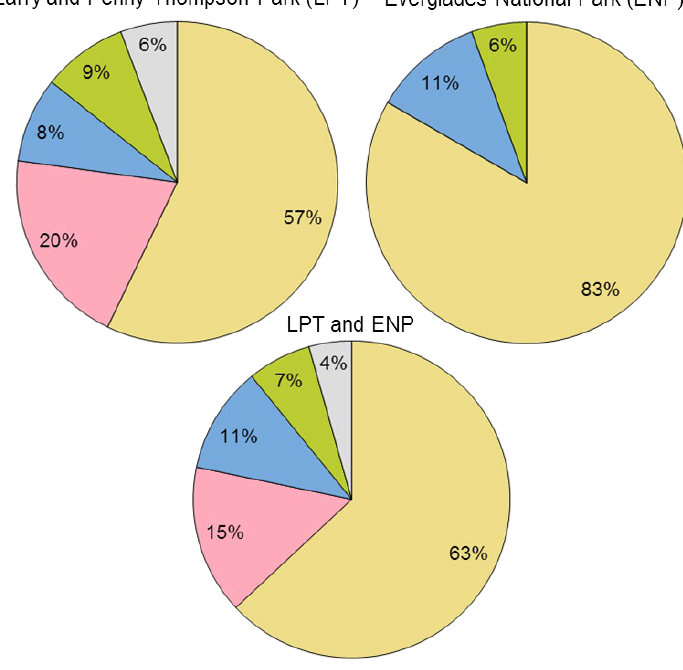
Figure 8. Relative usage of plant resources provided by Guettarda scabra , among arthropods in pine rockland habitats in south Florida USA. Percentages represent the fraction of species benefiting from a particular resource, with respect to the total number of species found in Larry and Penny Thomp- son LPT (35 species), in Everglades National Park ENP (18 species), or in both sites combined (46